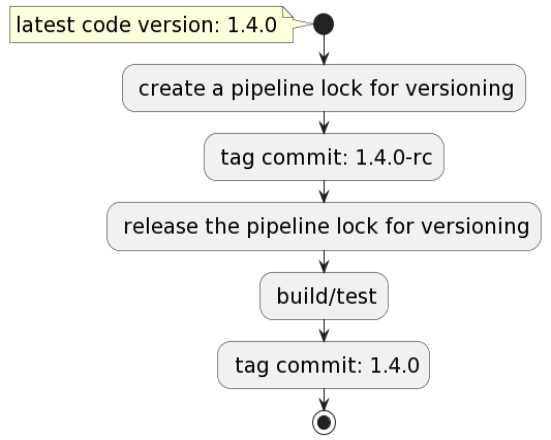
Figure 4. Versioning flow described.